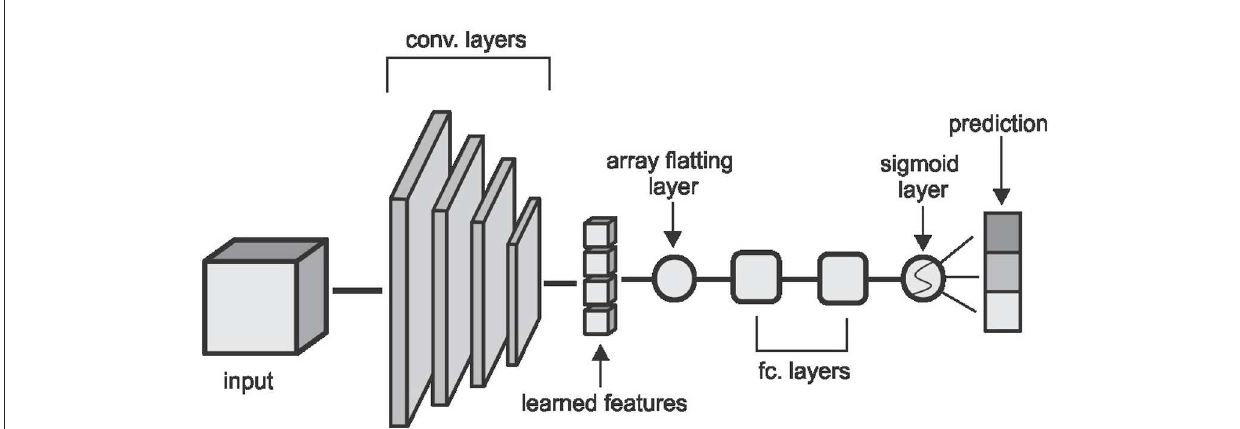
FIGURE3 The CNN architecture used in the classification task. Convolutional layers are made up of (5 × 5 × 5) kernels with a stride of (2 × 2 × 2) which reduces the volume by half of the input size on each layer. The first two layers extract 2 feature cubes and the last two layers extract 4 feature cubes each. The fully connected layers have 64 and 32 hidden nodes respectively and the convolutional and fully connected layers are followed by a non-linear hyperbolic tangent (tanh) activation function.